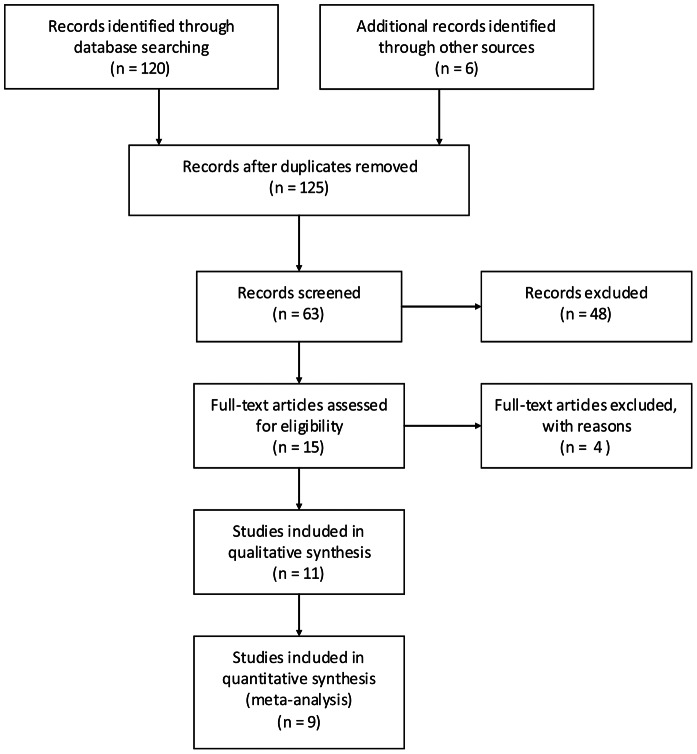
Flow diagram of identification of relevant studies.